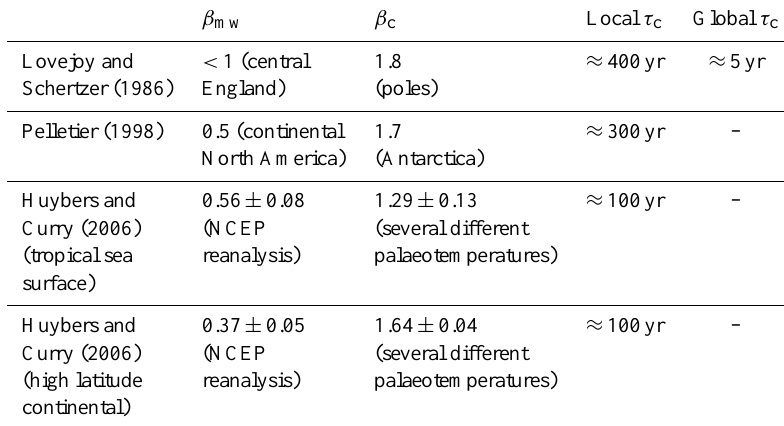
Table 1. Intercomparison of exponents and scales from macroweather ( β mw ) and climate ( β c ) exponents and transition scales from var- ious instrumental/palaeocomposite statistical analyses. The τ c values in the top two rows are from data north of 30 ◦ N and are probably anomalously